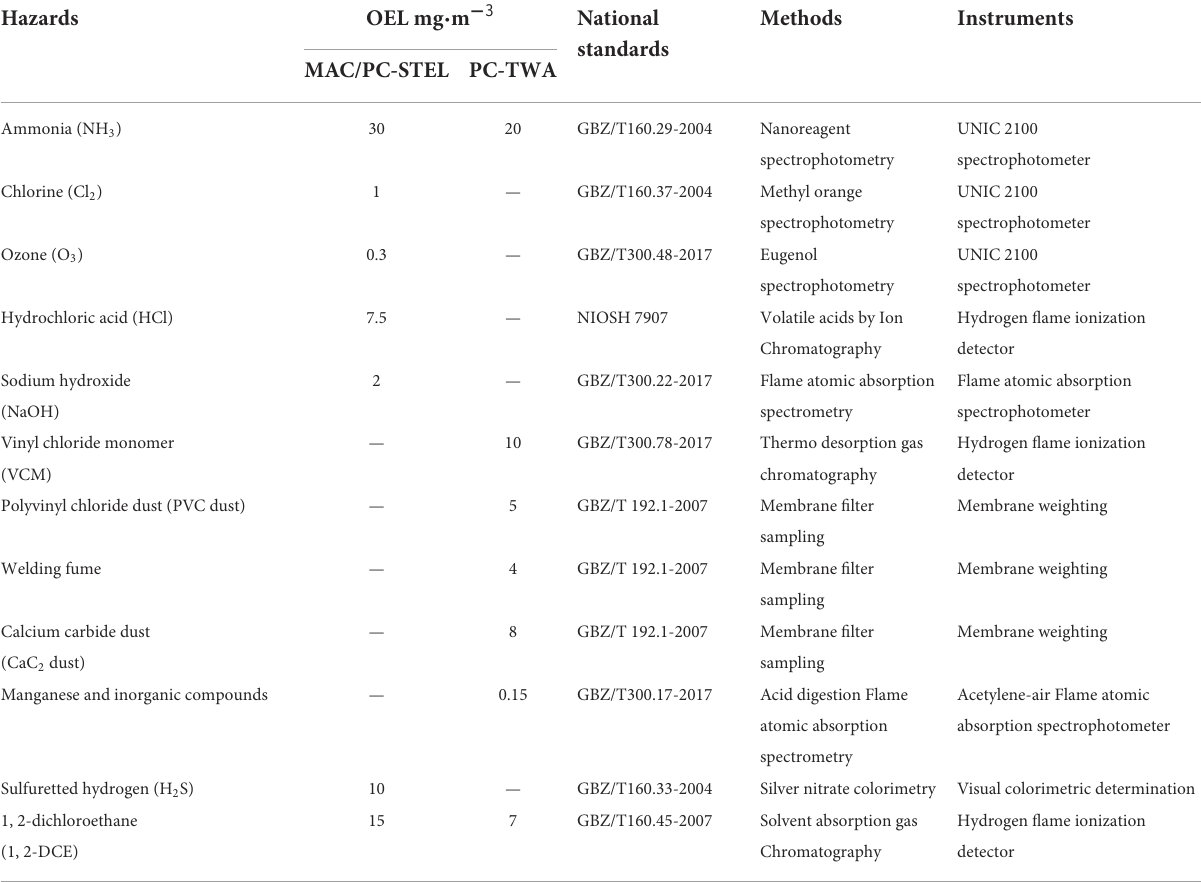
TABLE 1 Information of identified hazards and detection